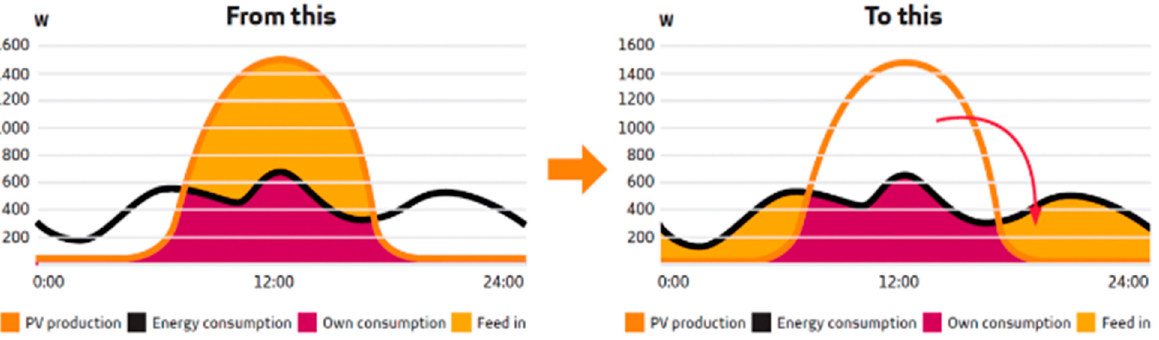
Figure 3. Solar PV self-consumption in South Africa.